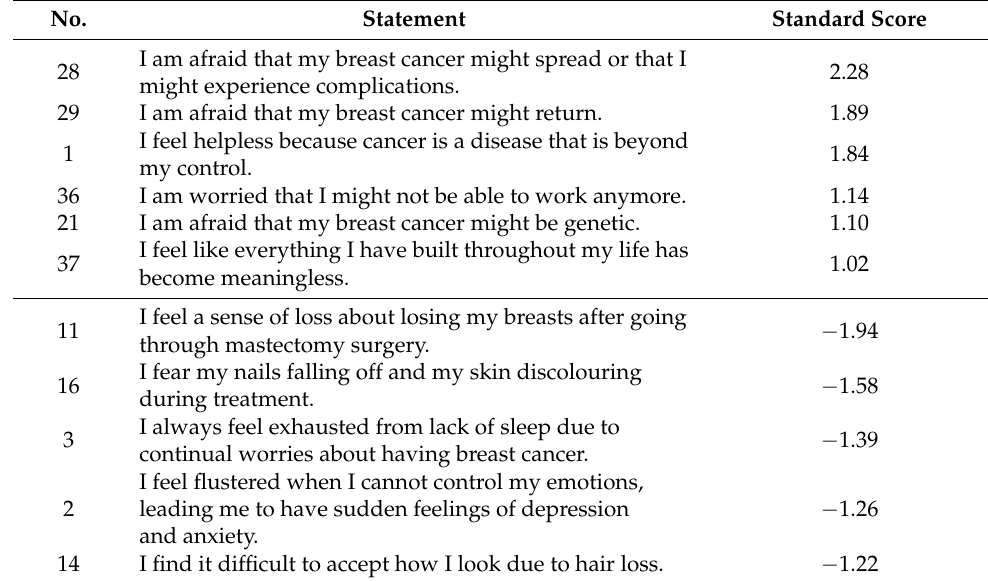
Table 6. Representative statements and standard scores (at least ± 1.00) of Type